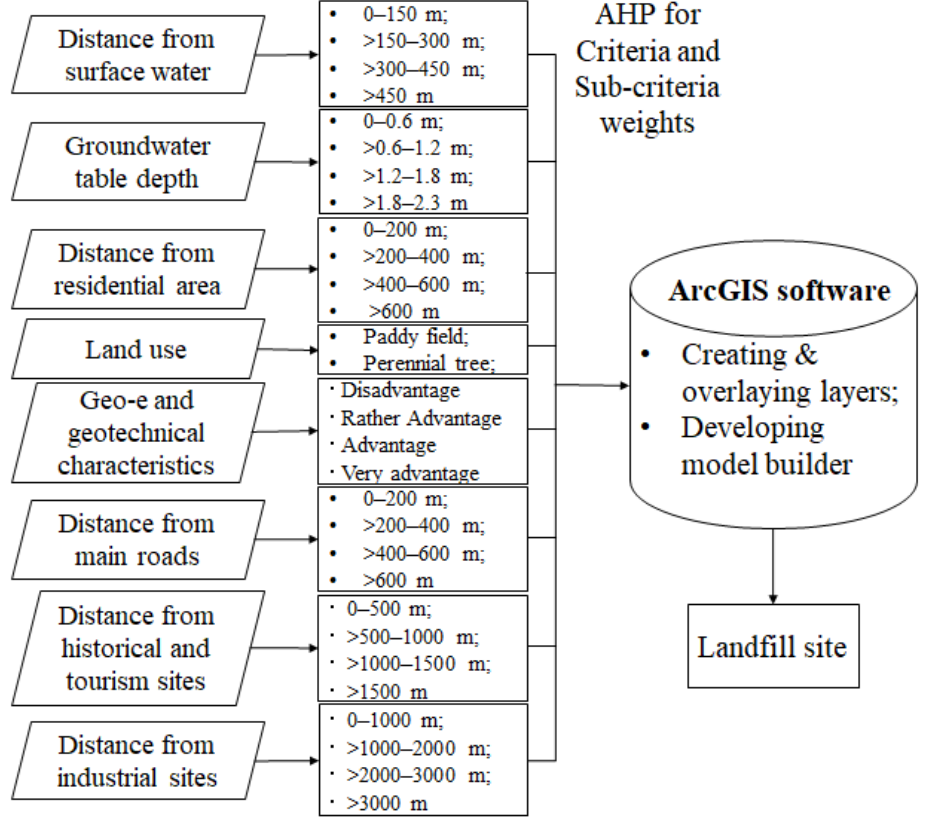
Figure 2. Procedure for simulating landfill site selection.